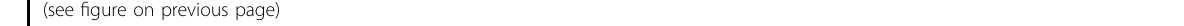
Fig. 4 Signaling pathways in the niche cells of testis. A Key genes and expression patterns in TGF β signaling pathway in Sertoli cells in cluster 11. Cluster-speci fi c expression is indicated by black circles. B Violin plots showing expression levels of TGF β signaling pathway genes. C TGF β signaling pathway in Sertoli cells, highlighting the key genes in red ovals. D Key genes and expression patterns in steroid biosynthesis process in cluster 12. Cluster-speci fi c expression is shown in black circles. E Violin plots showing expression levels of steroid biosynthesis genes. F Male steroid biosynthesis process in Leydig cells, highlighting the key genes in orange ovals. G UMAP map of krt8 showing expression in both cluster 11 and 12, indicated by black circles. H Immuno fl uorescence analysis using Krt8 antibody in ovotestis (second antibody, TRITC-conjugated immunoPure goat anti-rabbit IgG (H + L)). The nuclei were stained with DAPI. Positive signals were located in Sertoli and Leydig cells (arrows). The enlarged images on the right panel originated from the dotted squares on the left panel. Sg spermatogonia, Sc spermatocytes, St round spermatids, Lc Leydig cells, Se Sertoli cells. Scale bar: 20 µm. I UMAP map of cldn11 showing expression in both cluster 11 and 12, indicated by black circles. J Immuno fl uorescence analysis using Cldn11 antibody in ovotestis (second antibody, FITC-conjugated immunoPure goat anti-rabbit IgG(H + L)). The nuclei were stained with DAPI. Positive signals were located in Sertoli and Leydig cells (arrows). The enlarged images on the right panel originated from the dotted squares on the left panel. Lc Leydig cells, Se Sertoli cells. Scale bar: 20